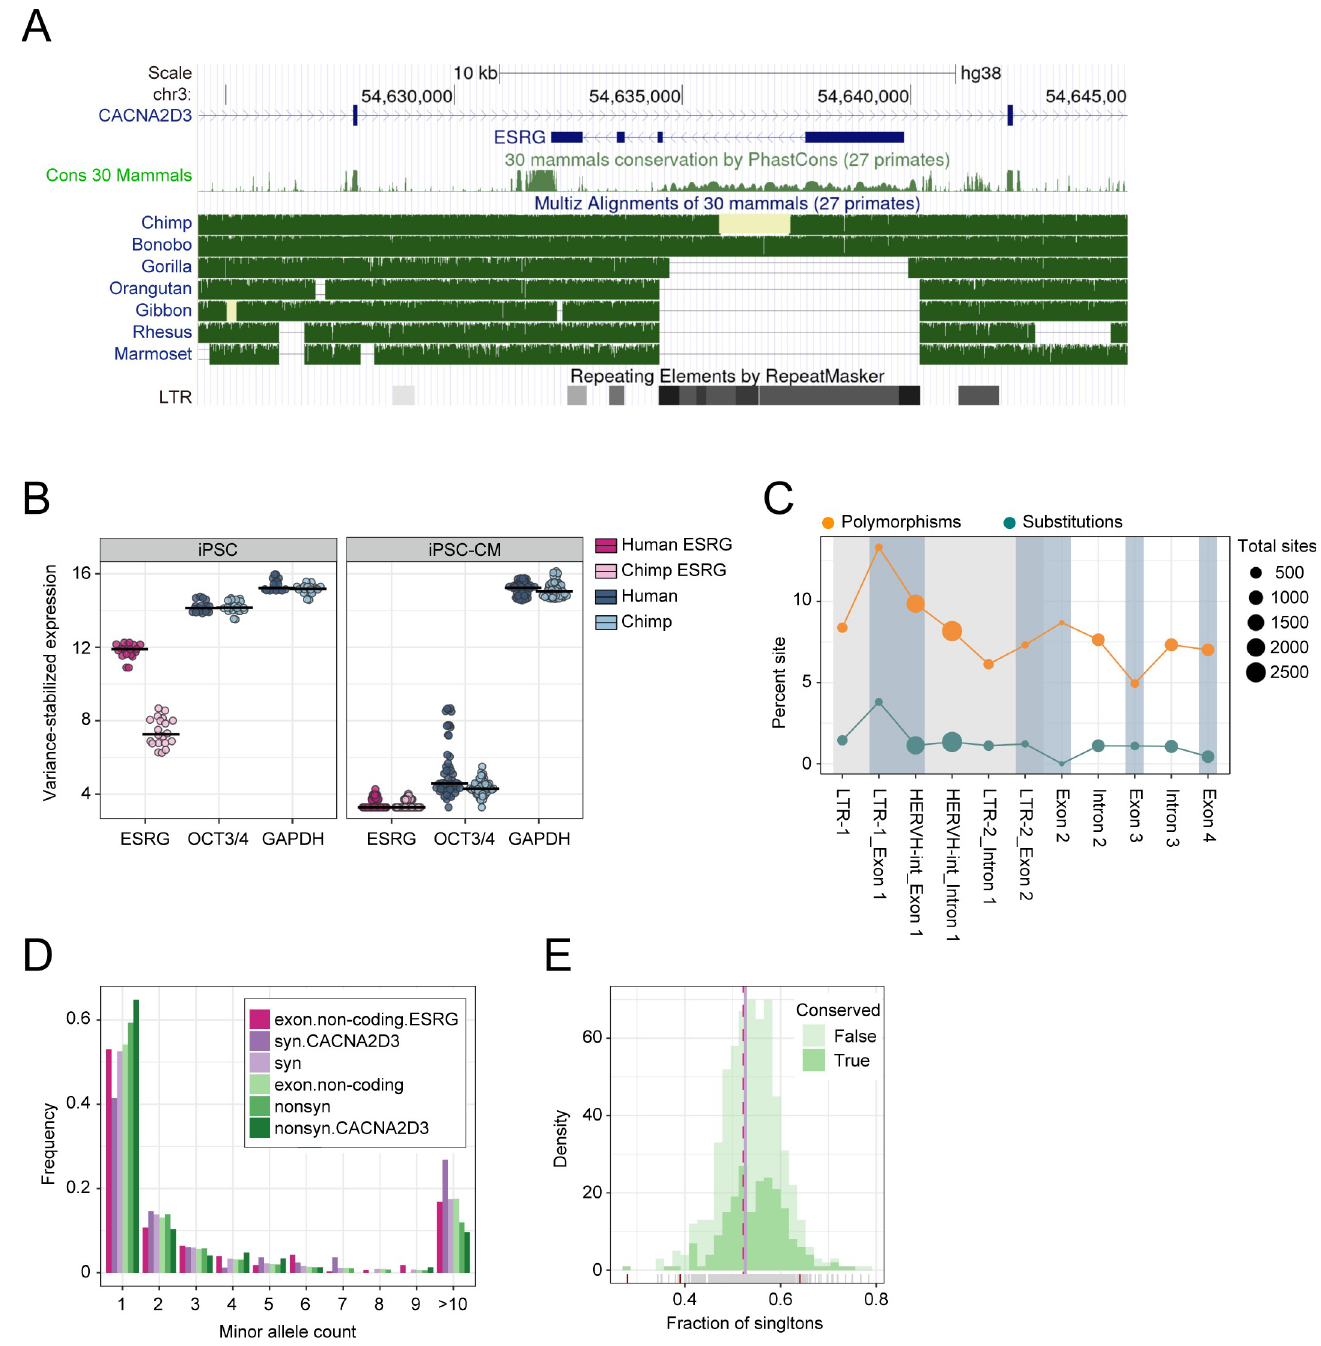
Fig 1. Conservation analysis of ESRG. (A) Modified screenshot from the UCSC genome browser showing the ESRG transcript in context to the RepeatMasker annotation, primate phastCons scores, and great ape and primate multiz-alignments. Note that the missing data in the chimpanzee were available in a newer chimpanzee assembly (panTro6) and was included in our later analysis. (B) DESeq2 normalized and variance stabilized expression in human and chimpanzee iPSCs and iPSC-derived cardiomyocytes (iPSC-CM). In iPSCs ESRG is similarly highly expressed as OCT3/4 and GAPDH, and completely downregulated in iPSC-CM. Moreover, in iPSCs ESRG is significantly higher expressed in humans than in chimpanzees (log 2 fold change = 3.85; p-adj < 10 − 17 ; S2 Table). (C) Fraction of substitutions and SNVs across exons and introns of ESRG. Both diversity and divergence are highest in the LTR-region of exon 1. (D) Site frequency spectrum across 30,000 chromosomes across human populations for ESRG exons, other non-coding exons, synonymous and nonsynonymous sites of next gene CACNA2D3 and across the genome. (E) Distribution of the fraction of singletons for conserved lncRNAs ( > 5% sites with PhastCons > 0.9) and other lncRNAs with at least 50 SNVs. Only very few have a singleton fraction that differs significantly from the neutral expectation as derived from synonymous sites ( χ 2 -test; p < 0 . 05 , red tick- marks on the x-axis).